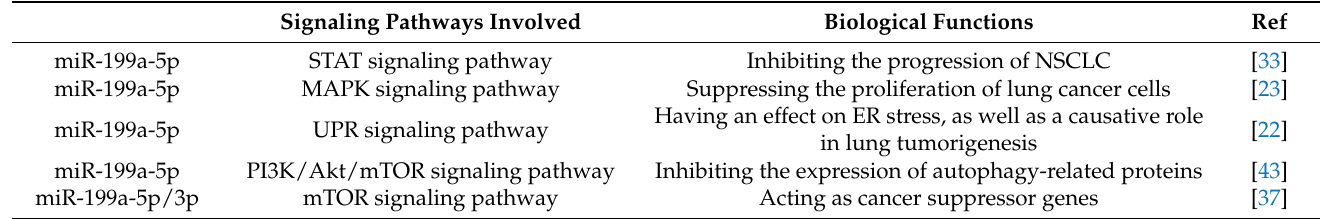
Table 2. miR-199a is involved in the signaling pathway in lung